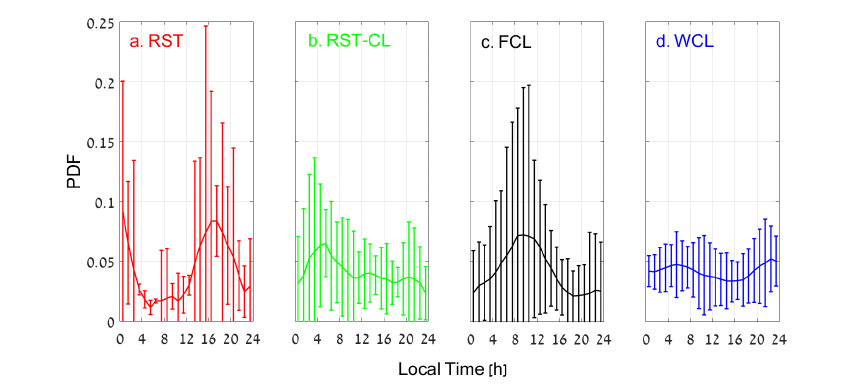
Figure 6. Diurnal probability density function (PDF) of lightning strokes in local time according to the four synoptic systems. The integral under each curve equals 1. Error bars indicate interannual SD.